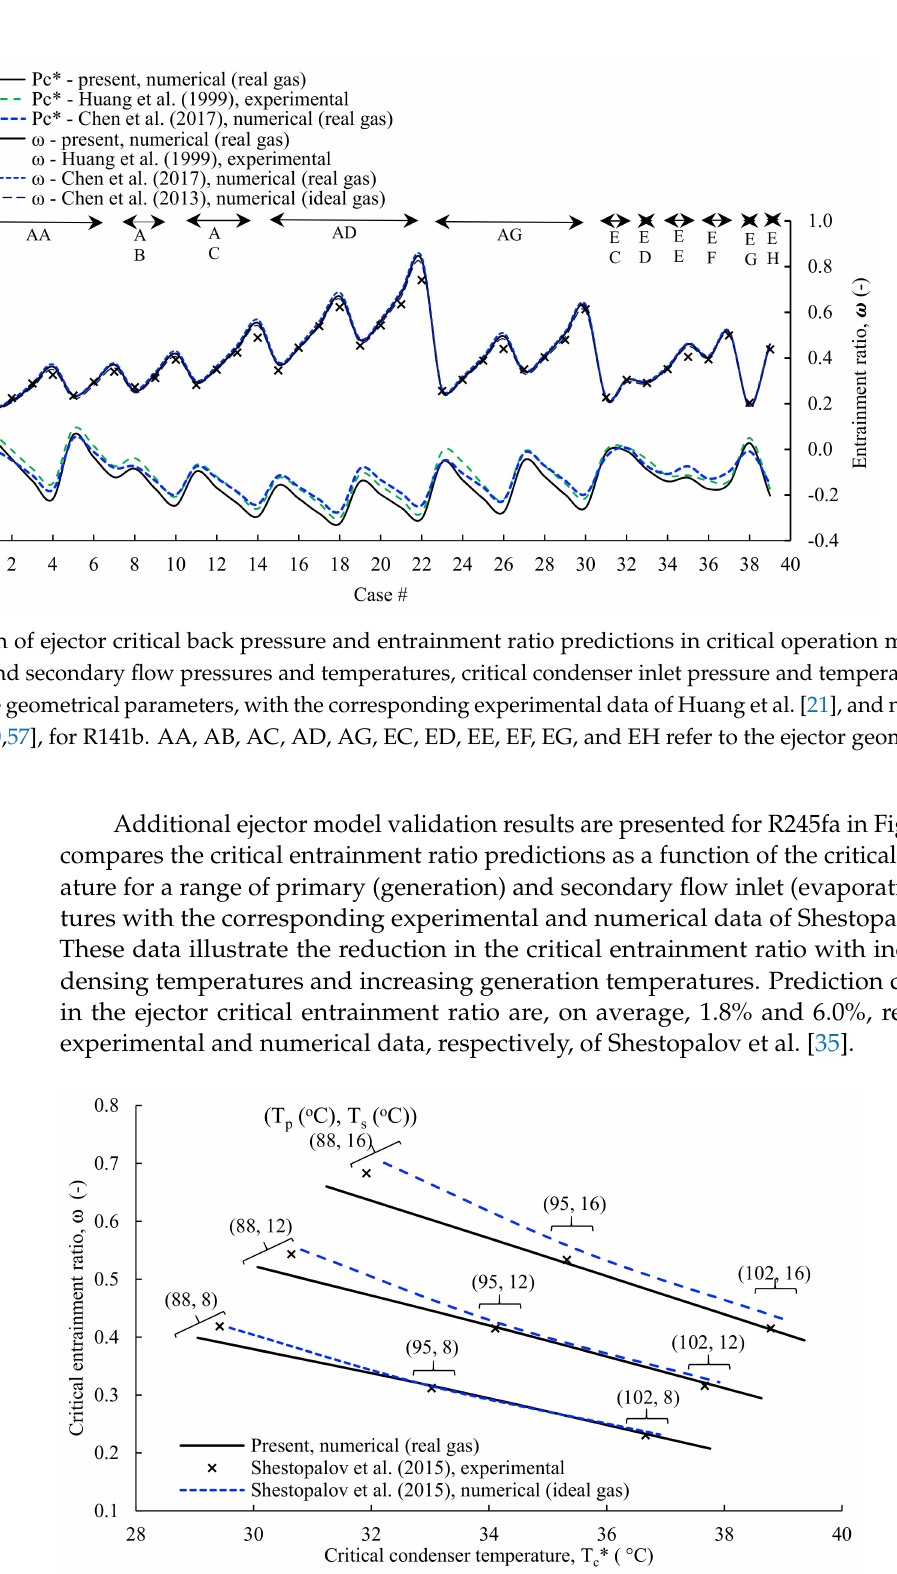
Figure 5. Comparison of ejector critical entrainment ratio predictions as a function of critical con- denser temperature for several primary inlet (generation) and secondary inlet (evaporation) tempera- tures, with the corresponding experimental and numerical data of Shestopalov et al. [35] for